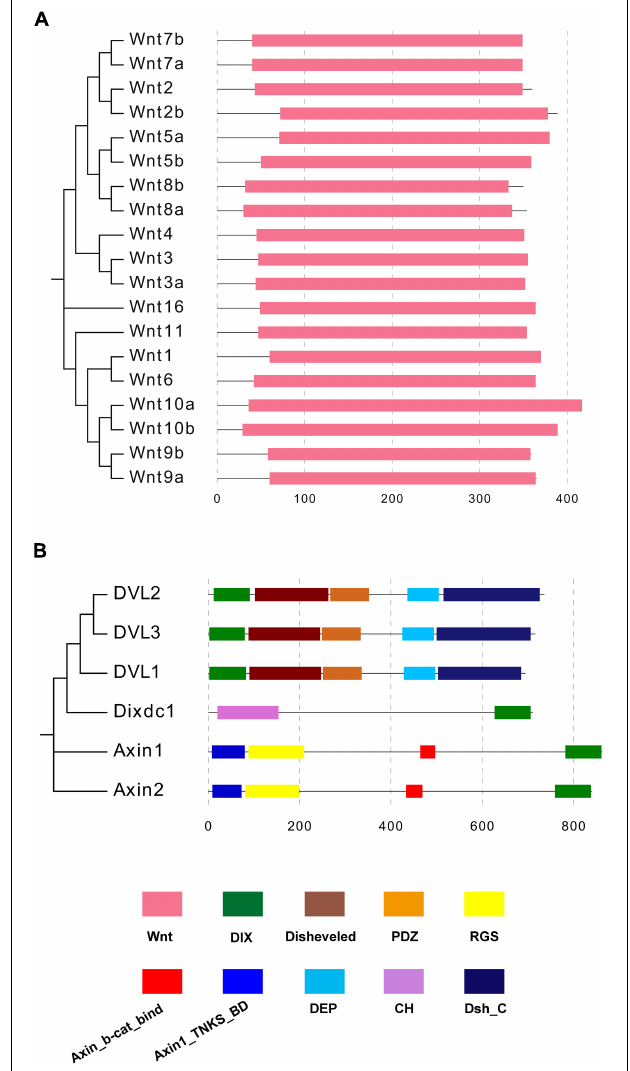
FIGURE 5 | (A,B) Domain compositions of mouse Wnt and DIX proteins. Domain organization information of mouse Wnt and DIX proteins was obtained in the Pfam database and domains are marked in different